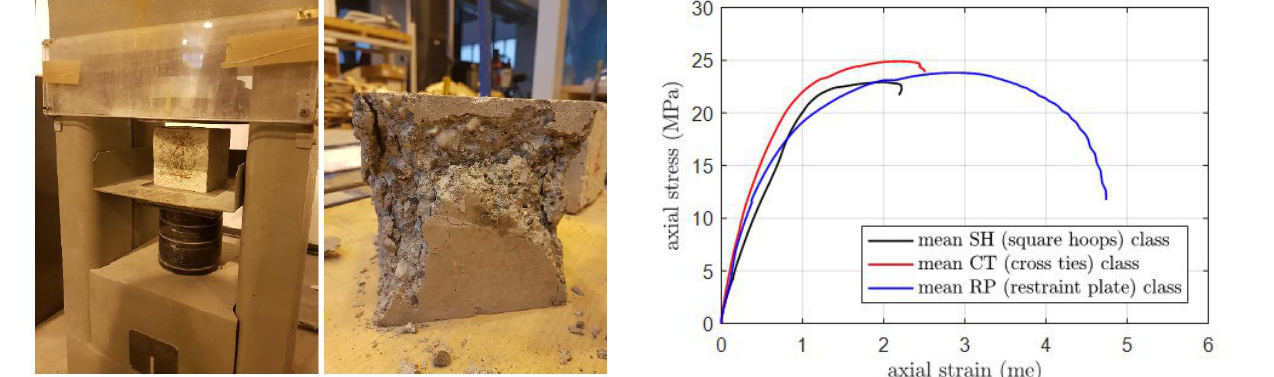
Figure 9: Mean stress-strain curves for medium-strength concrete columns with different arrangements of transverse reinforcement